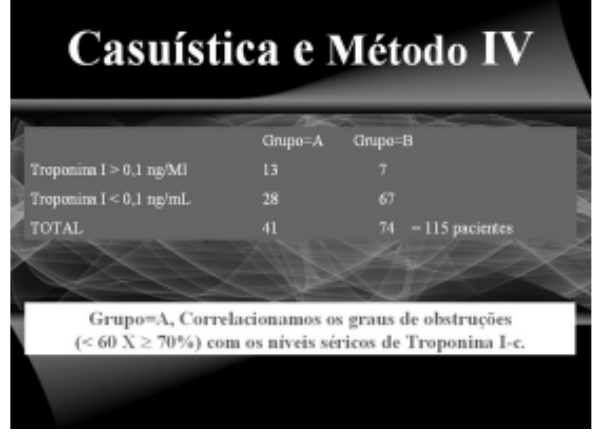
Tabela 1. Os grupos A e B com os respectivos níveis séricos de